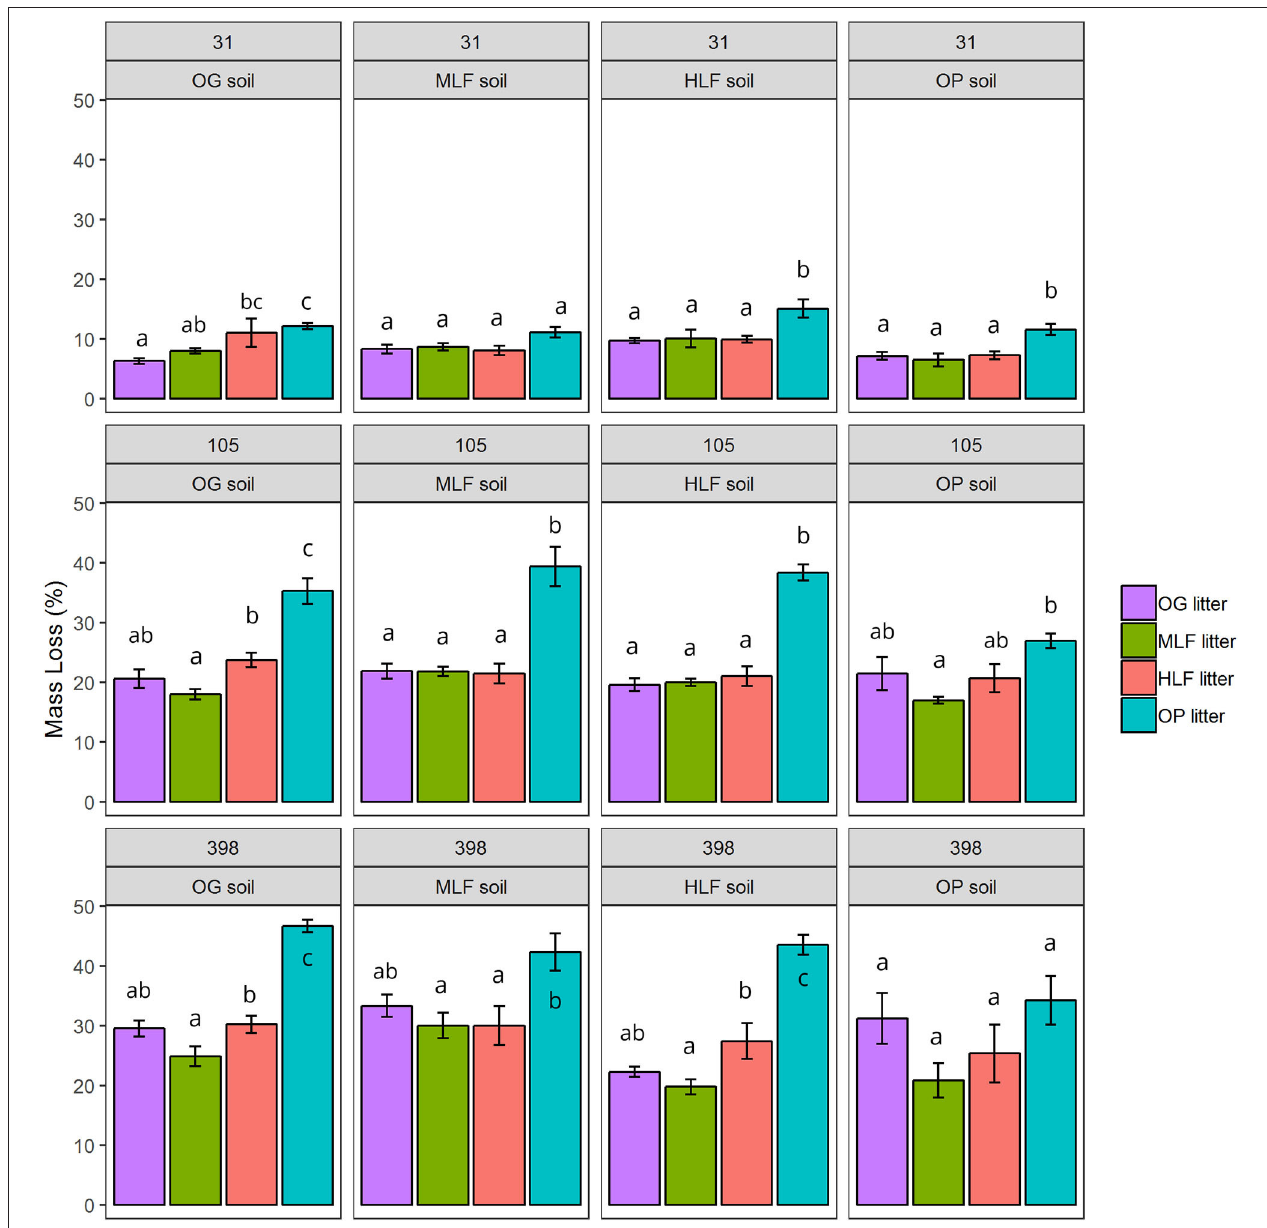
FIGURE 3 | Mean litter mass loss from microcosms consisting of soils and mixed litter collected from old growth (OG) forest, moderate logged forest (MLF), heavily logged forest (HLF), and oil pam (OP). The four litter mixtures and soils were combined in a fully—factorial design (16 unique combinations) and destructively harvested after 31, 105, and 398 days. Values are mean percentage mass loss ± 1 SE of OG, MLF, HLF, and OP litter after 31, 105, and 398 days of decomposition. Superscript letters denote pairwise significant differences at P < 0.05 within each panel from ANOVA and Tukey’s honestly significant difference post-hoc